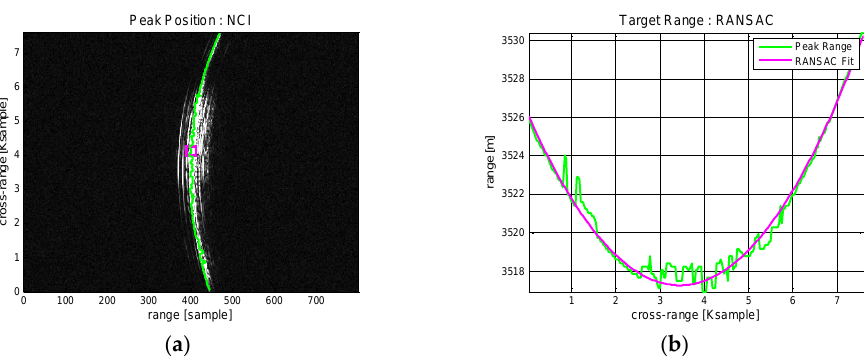
Figure 15. Cessna 208 ISAR data after range compression: ( a ) Range compressed pattern; ( b ) Range tracking result.